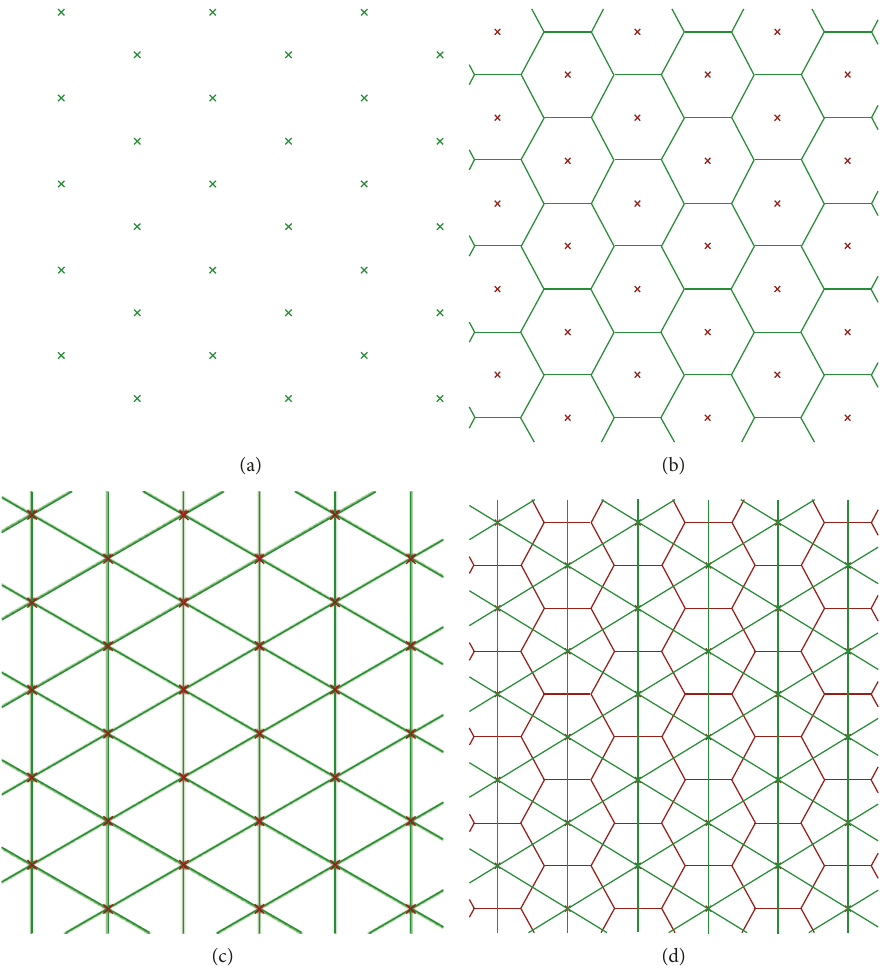
Figure 8: Cell complex dual: (a) regular seed, (b) primal cell complex (Voronoi), (c) dual cell complex (Delaunay), and (d) primal and dual cell complexes